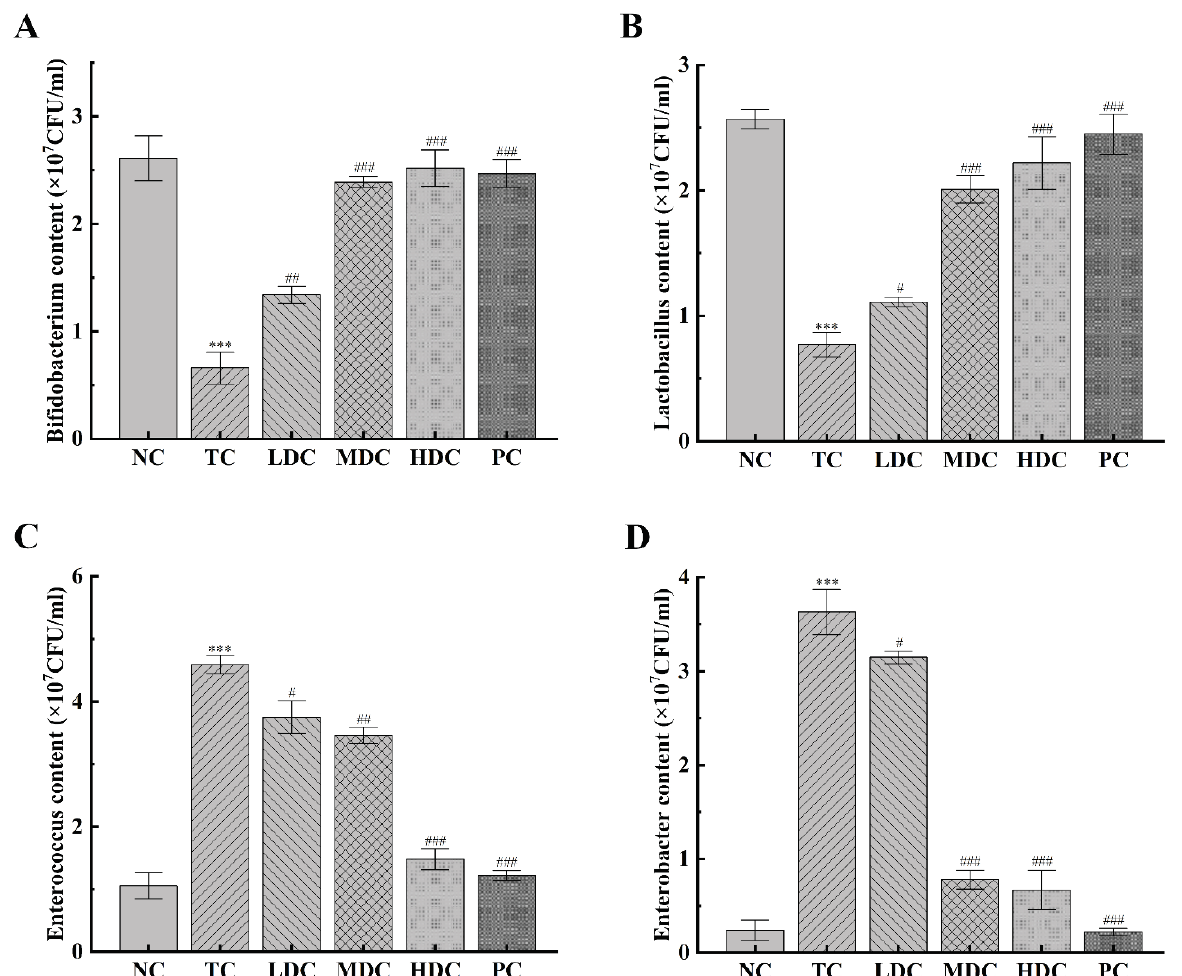
Figure 6. The effect of PSS on the number of important bacteria in the gut was investigated. The number of ( A ) Bifidobacterium, ( B ) Lactobacillus, ( C ) Enterococcus, and ( D ) Enterobacter in the intestinal tract of mice was detected. Data are presented as mean ± SD (n = 8); *** p < 0.001 compared to the NC group; # p < 0.05, ## p < 0.01, and ### p < 0.001 compared to the TC group.